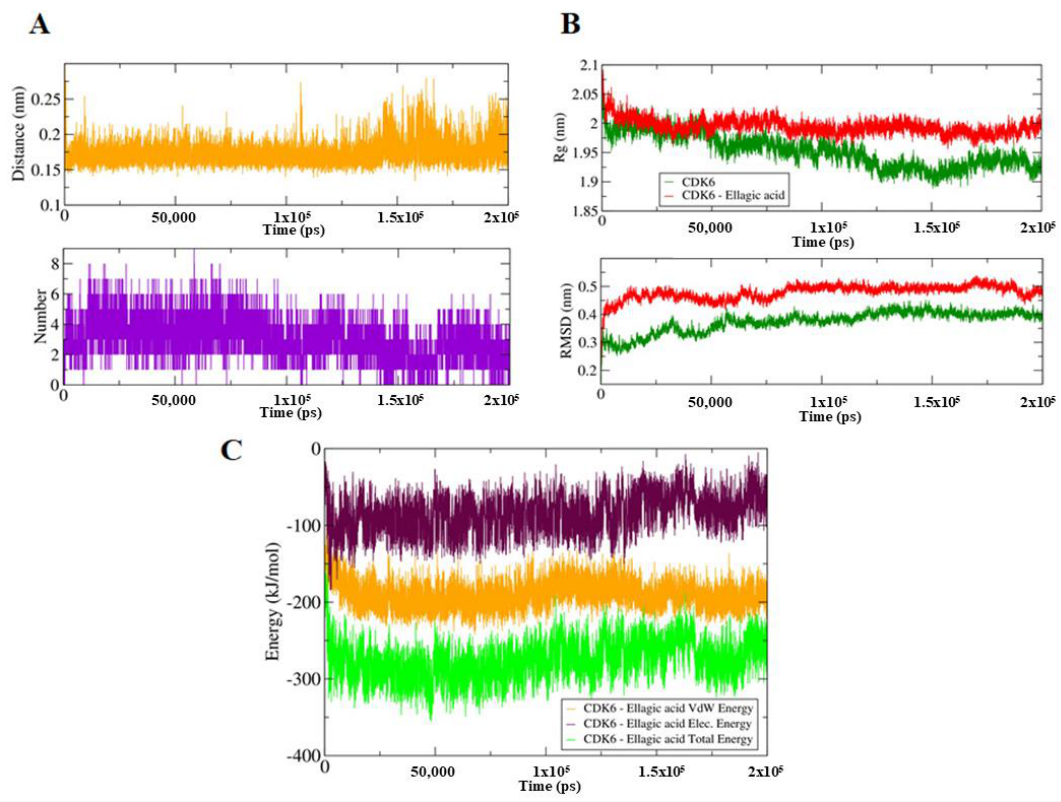
Figure 2. (A) Upper panel shows a plot of changes in the distance between the CDK6 and EA. The lower panel shows the number of hydrogen bond fluctuation curve highlighting the changes in the observed number . (B) The upper panel shows the R g curves, an indication of compactness. The lower panel corresponds to the RMSD plots to highlight the conformational changes in the CDK6 upon EA binding. (C) The MMPBSA-based generated curves showing changes in the total, electrostatic, and van der Waals energies between the CDK6 and CDK6-EA complex.